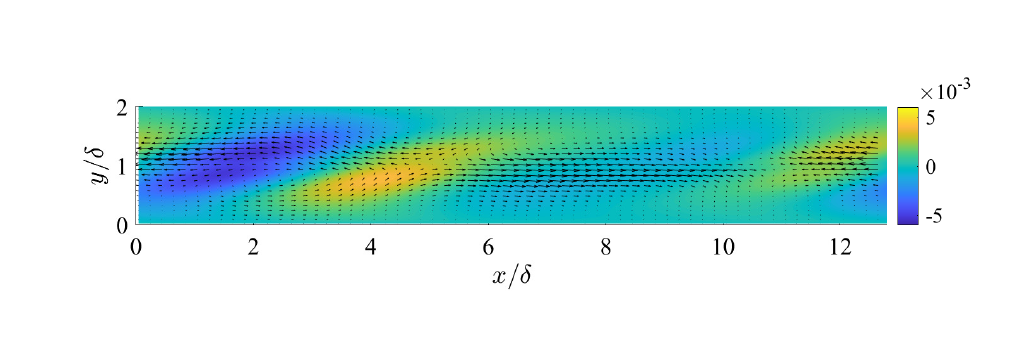
Figure 14. Large-scale flow in the decomposed velocity field for Re = 100 and Wi = 100. Vector: ( u l , v l ). Contour: w l ∗